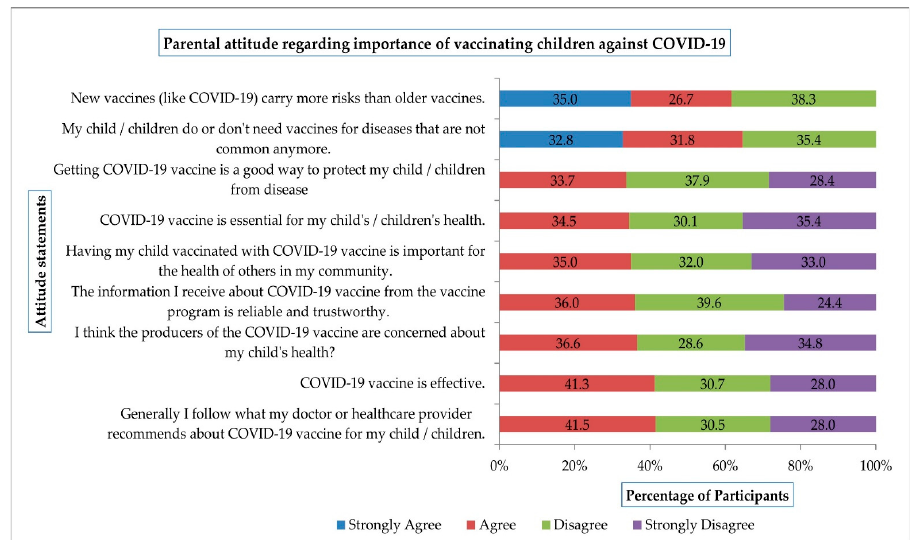
Figure 1. Parental attitude regarding the importance of COVID-19 vaccination among children.